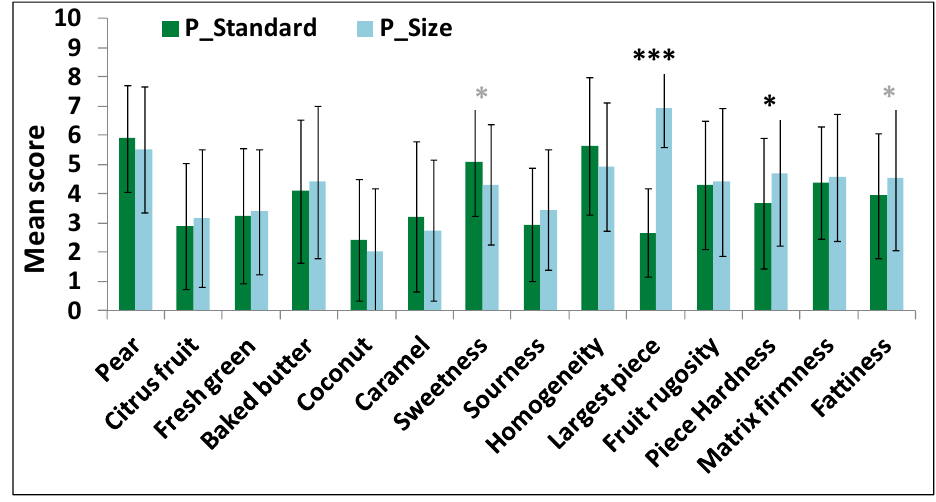
Figure 5. Sensory profiles (mean value across subjects and replicates and standard deviations) of P_Standard and P_Size products for each sensory attribute (level of